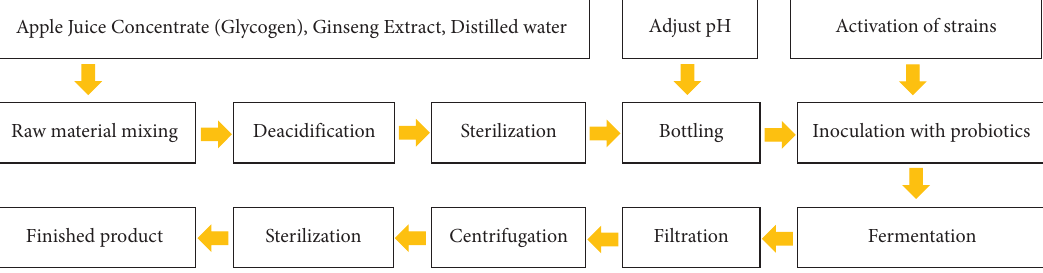
Figure 1: Te main steps of ginseng jiaosu production